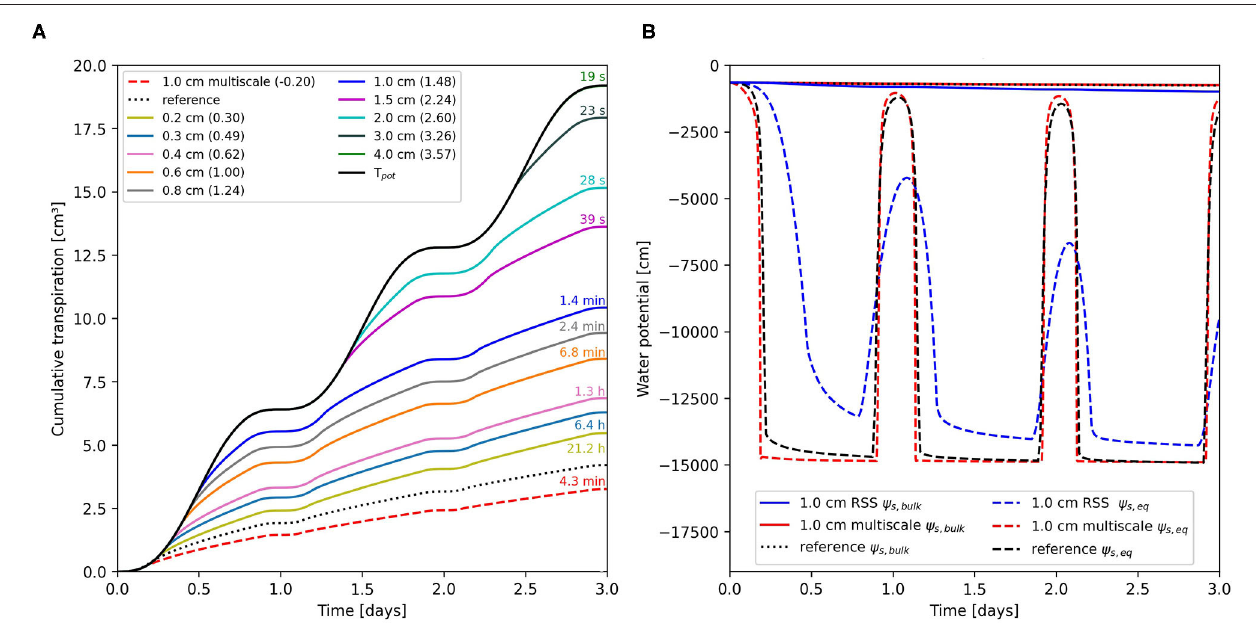
FIGURE 1 | (A) Cumulative transpiration of the numerical reference solution (dotted), the multi-scale model (dashed), and the root system scale (RSS) model at different soil resolutions (solid) for the loamy soil scenario benchmark C1.2 at initial ψ s , top = − 659.8 cm. Values in parentheses indicate the relative error (RE), numbers above lines indicate the wall-clock time required to compute the respective simulation. (B) Equivalent soil water potential, ψ s , eq , (dashed) for the reference solution (black), and for RSS (blue), and multi-scale model (red) while using a bulk soil resolution of 1 cm. Blue and red solid lines show the mean bulk soil water potential, ψ s , bulk , of the soil domain in RSS and multi-scale model, ψ s , bulk of the reference solution is shown with a black dotted line.